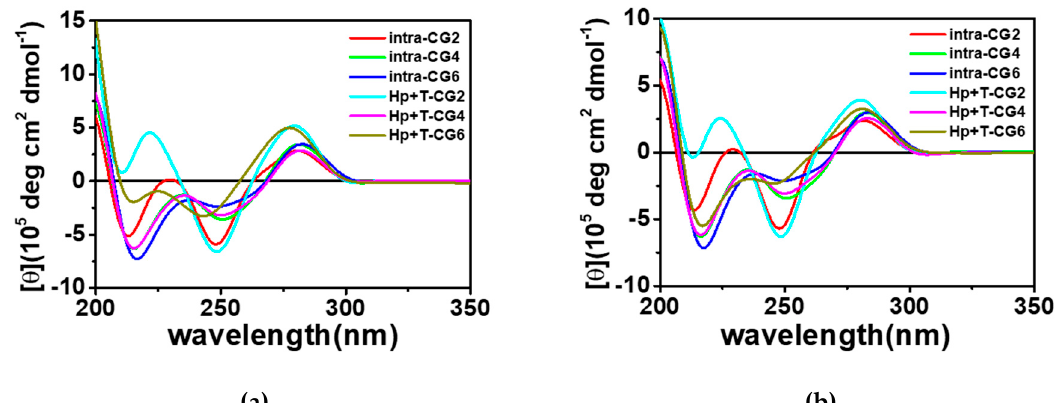
Figure 2. Circular dichroism (CD) spectra of Intra-CG2, Intra-CG4, Intra-CG6, Hp-CG2 + T-CG2, Hp-CG4 + T-CG4, and Hp-CG6 + T-CG6 in a buffer containing 50 mM 2-morpholino-ethanesulfonic acid (MES) and 0.1 M KCl at pH 6.0 in the absence ( a ) and presence ( b ) of PEG 200. The total DNA concentration was 20 μ M.